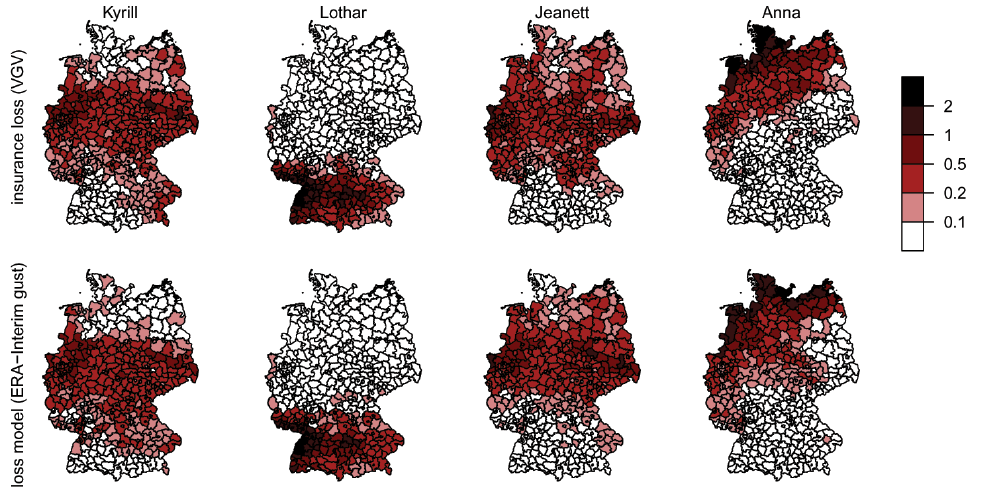
Fig. 6. Spatial distribution of losses for the four most loss-intensive single events in the period 1997 to 2007: insurance data (top row) and calculated losses by applying the loss model to ERA-Interim gust (bottom row). For each event the local losses were calculated using the linear regression derived from the other 33 events, leaving out the particular storm itself. For each administrative district the loss ratio is shown relative to the country-wide cumulated loss for the specific event (unit: